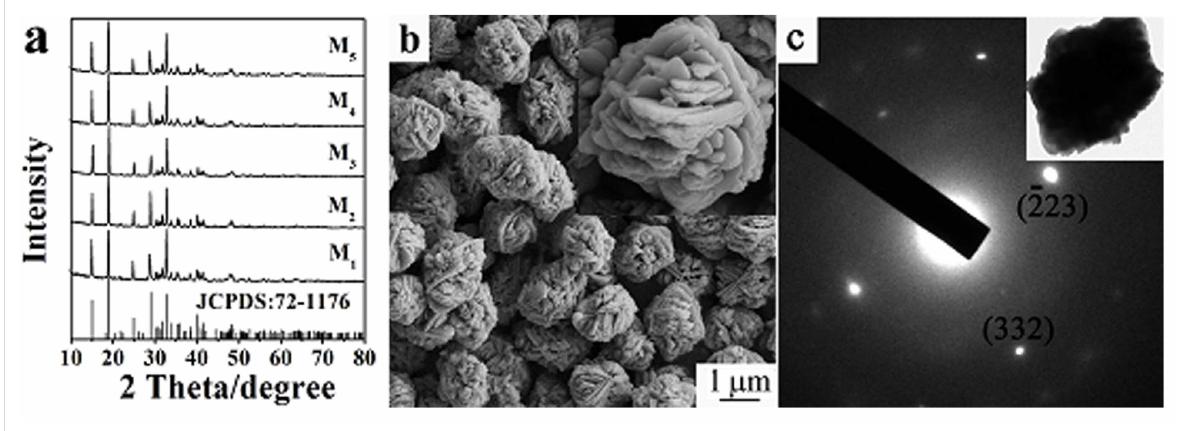
Figure 1: (a) XRD patterns of Ag@AgSCN nanostructures with different molar ratios of Ag to AgSCN. An (b) SEM image and (c) SAED pattern of the Ag@AgSCN nanostructure (sample M 2 ).